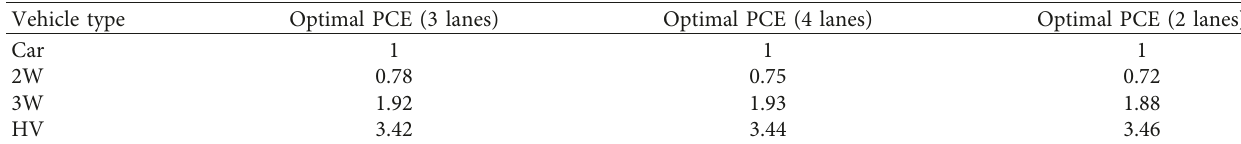
Table 5: Sensitivity of PCE estimates to the number of lanes.